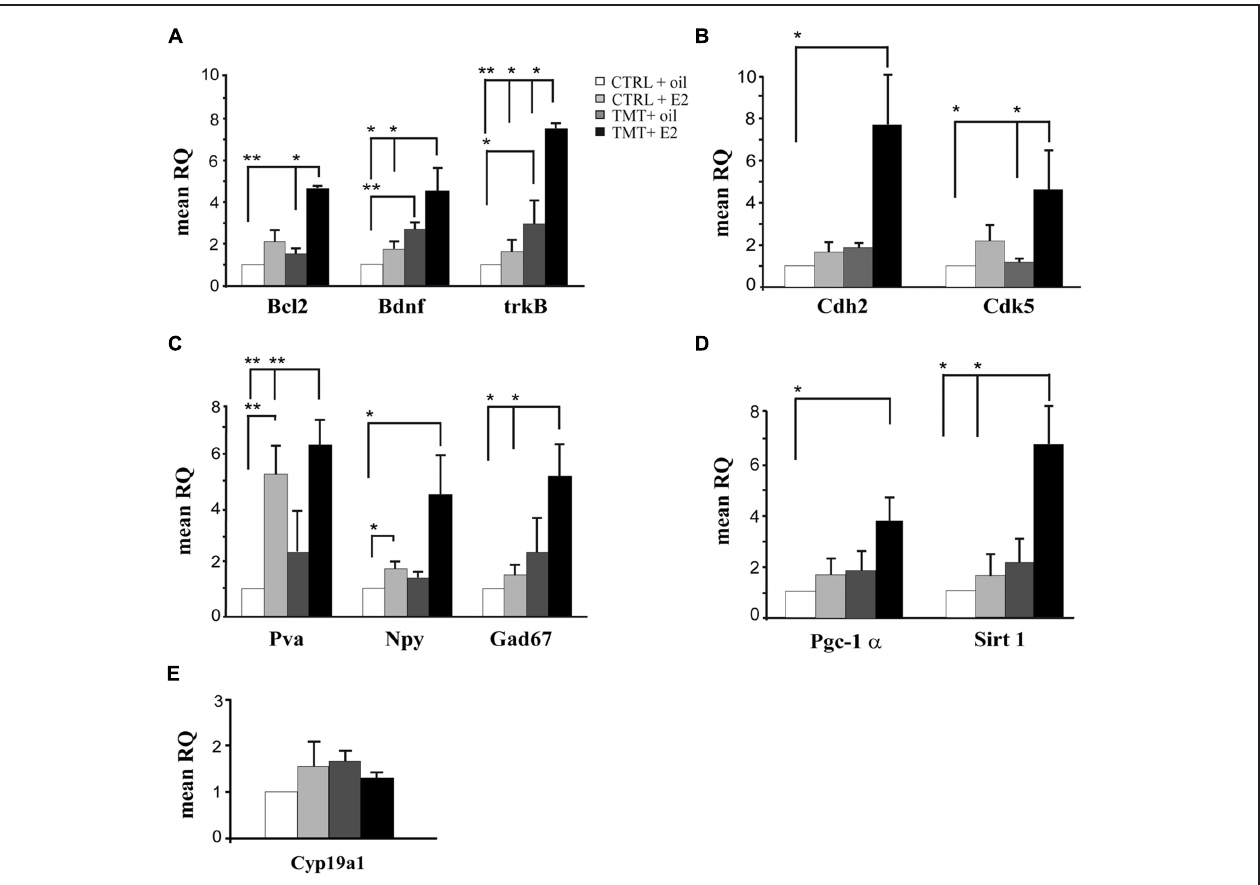
FIGURE 1 | Expression levels of genes modulated by E2 administration in the hippocampus of TMT-treated rats. Bar graphs represent results of quantitative real time-PCR obtained using the DDCt method for the calculation of relative quantity (RQ) of the following genes: (A) Genes involved in neuroprotection ( Bcl2, Bdnf, and trkB ); (B) Genes involved in synaptogenesis ( Cdh2 and Cdk5 ); (C) Markers of interneurons ( Gad67, Pva, Npy ). (D) Genes involved in PV transcription ( Pgc-1 α and Sirt 1 ). (E) Gene related to local E2 biosynthesis : aromatase (Cyp19a1) . ∗ p < 0.05, ∗∗ p < 0.001, calculated on mean (cid:2) Ct across biological